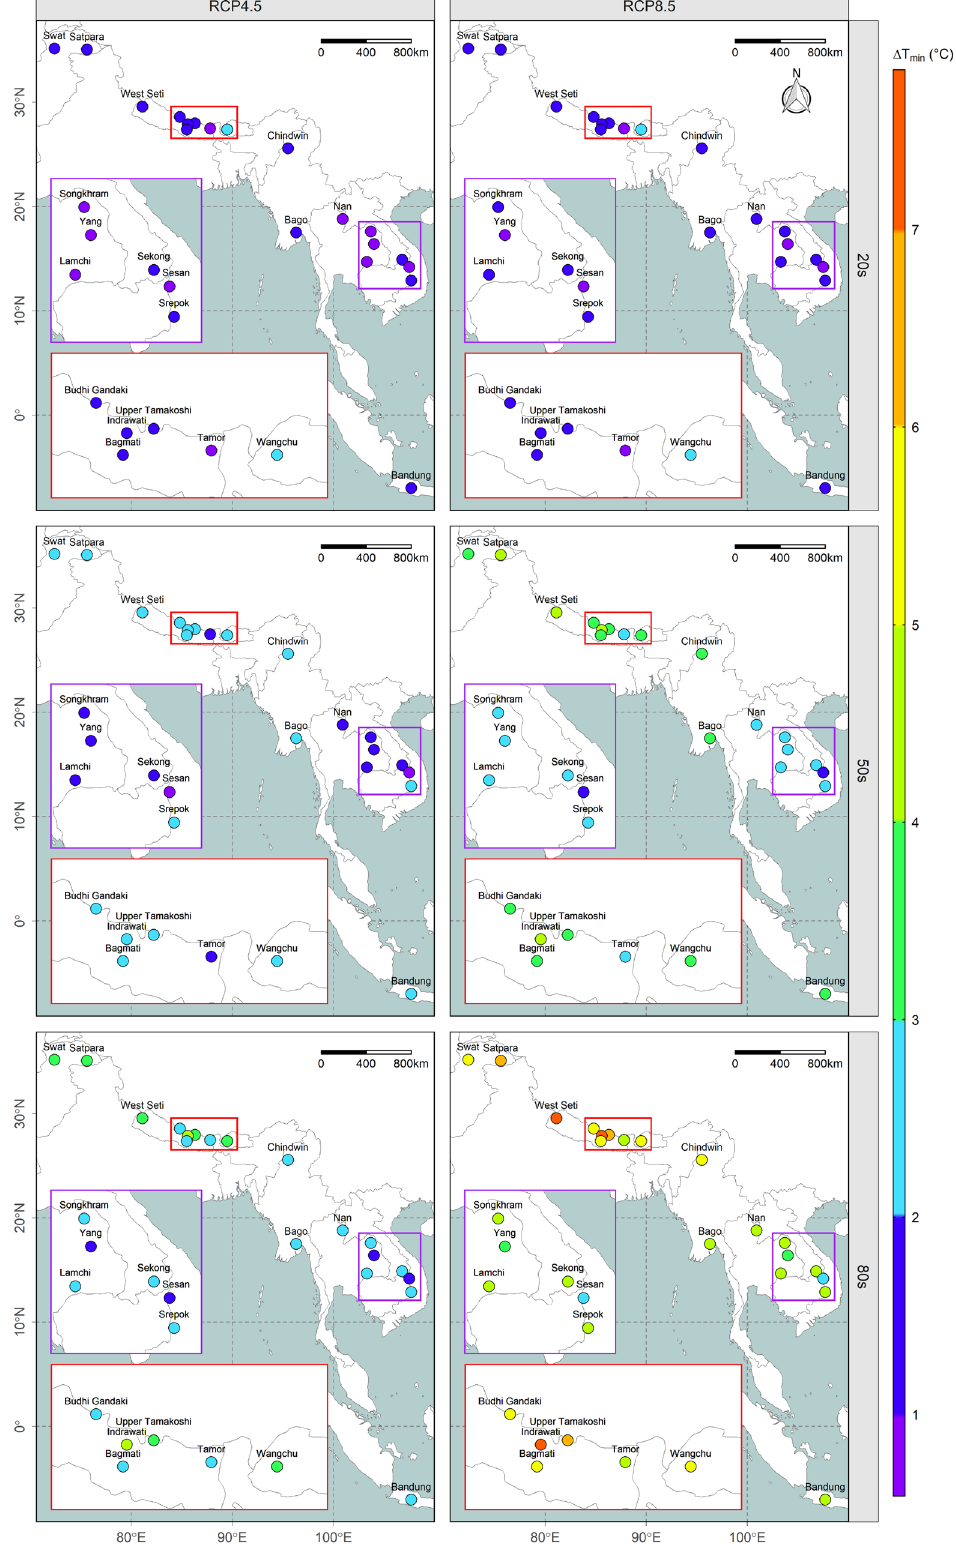
Figure 2. Spatiotemporal variation in the annual minimum temperature anomaly (absolute change). The results are from an ensemble of GCMs, with each facet corresponding to different emission scenario (RCP4.5 or RCP8.5) during various time periods (20 s, 50 s, or 80 s) as indicated at the top and left side of the map, respectively while the two insets are enlarged and colour-coded 20–22